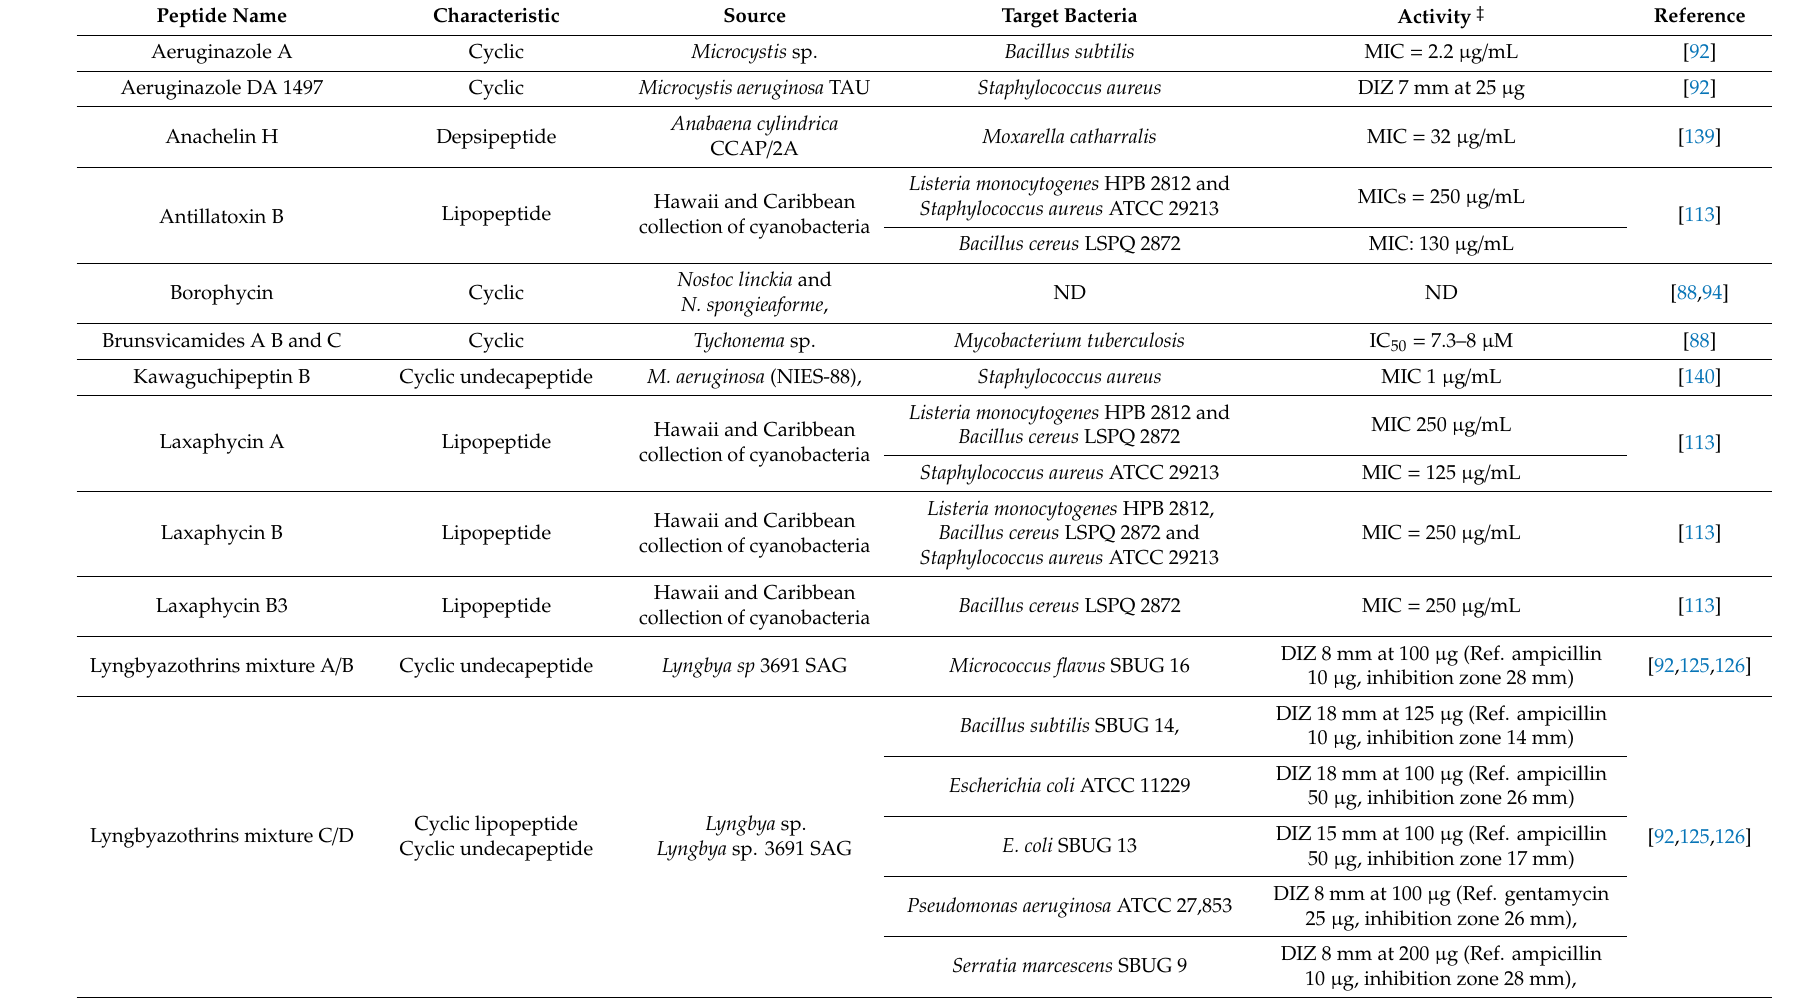
Table 3. Cyanobacterial peptides with antibacterial